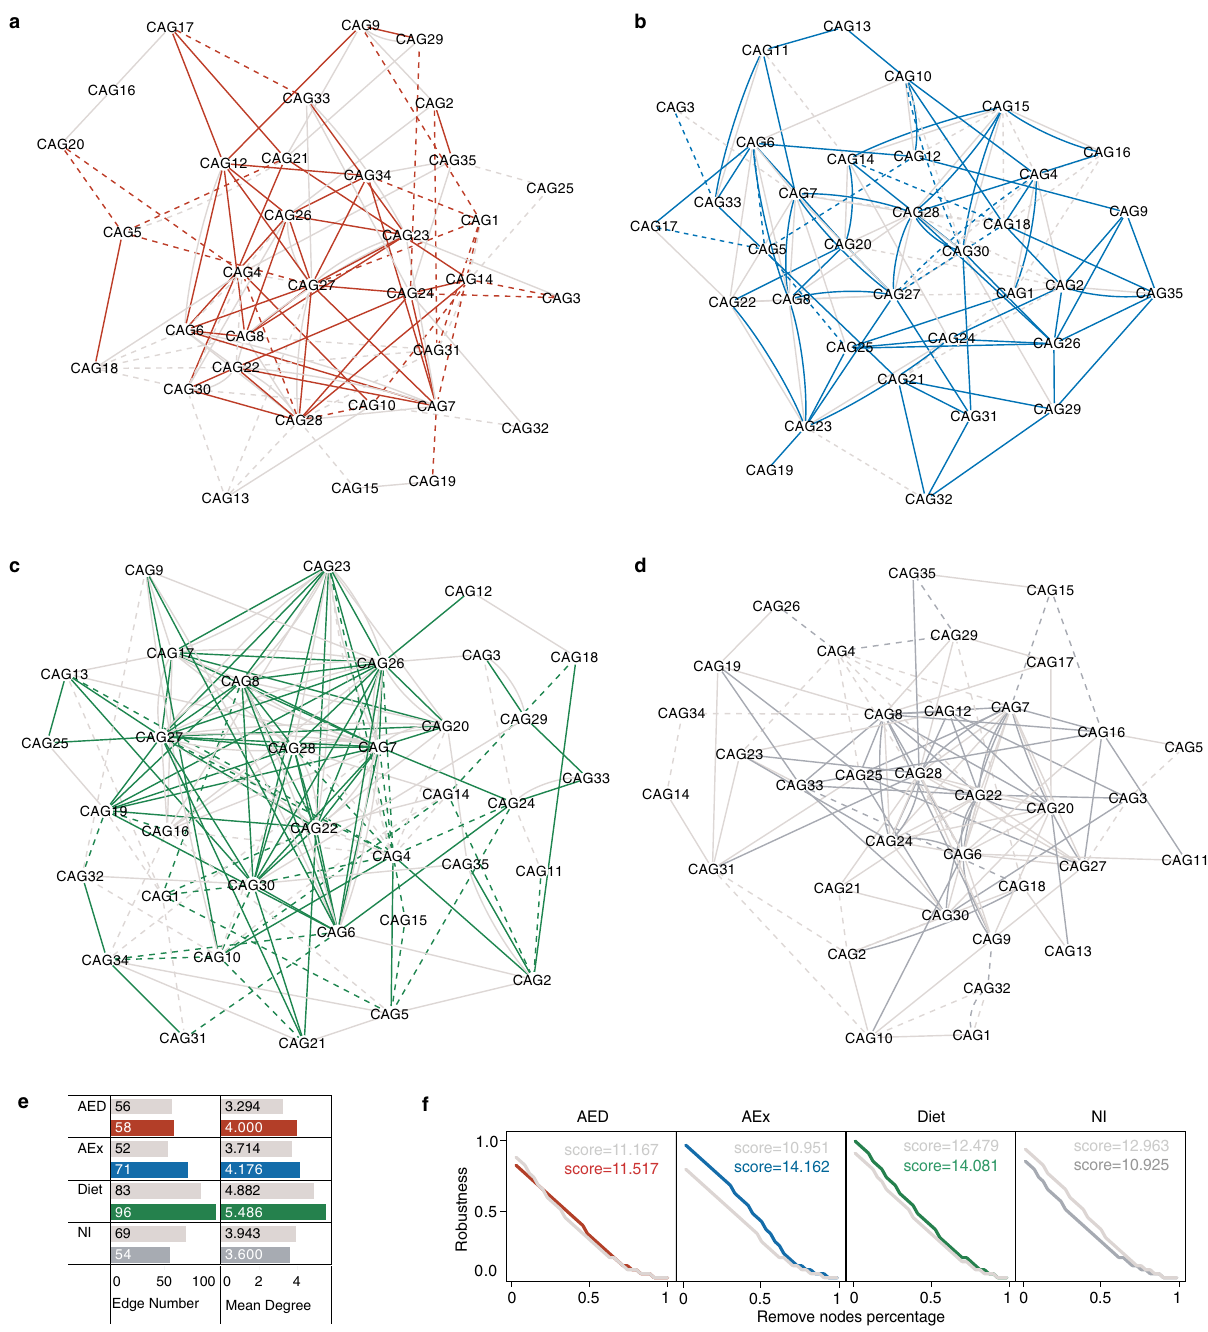
Fig. 4 Co-occurrence networks before and after intervention in paired participants. a – d Co-occurrence networks of CAGs (co-abundance groups) before and after intervention in different groups ( a : AED: n = 20; b : AEx: n = 20; c Diet : n = 21; d : NI: n = 15). The nodes represent CAGs and the edges represent statistically signi fi cant differences ( p < 0.05) via Spearman correlation between CAGs without adjustment. The style of the edge is set to a dashed line and a solid line, which represent negative and positive correlation, respectively. Gray edges indicate correlation before intervention; colored edges indicate correlation after intervention. e Network connection properties. f Network robustness